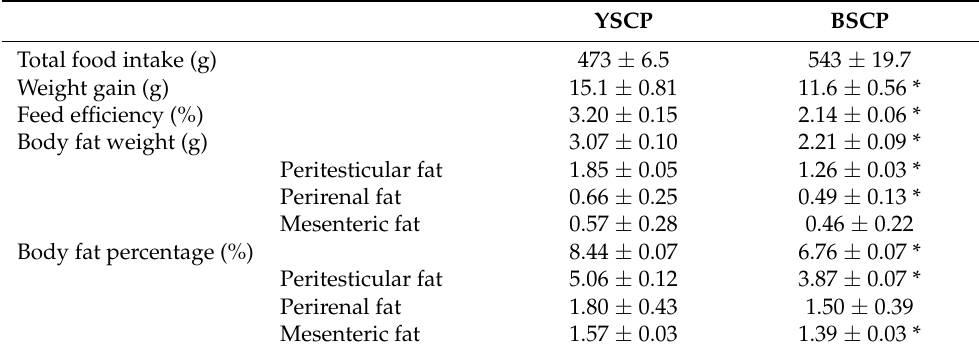
Figure 2. Effect of yellow soybean seed coat powder (YSCP) or black soybean seed coat powder (BSCP) on the average body weight of mice fed high-fat diets for 10 weeks. ■ , mice given BSCP; □ , mice given YSCP. Values are presented as the mean ± standard error (SE, n = 10 or 11). Differences between groups were compared using Student’s t -test. An asterisk indicates a significant difference ( p < 0.05). Table 3. Total food intake and body fat weights of